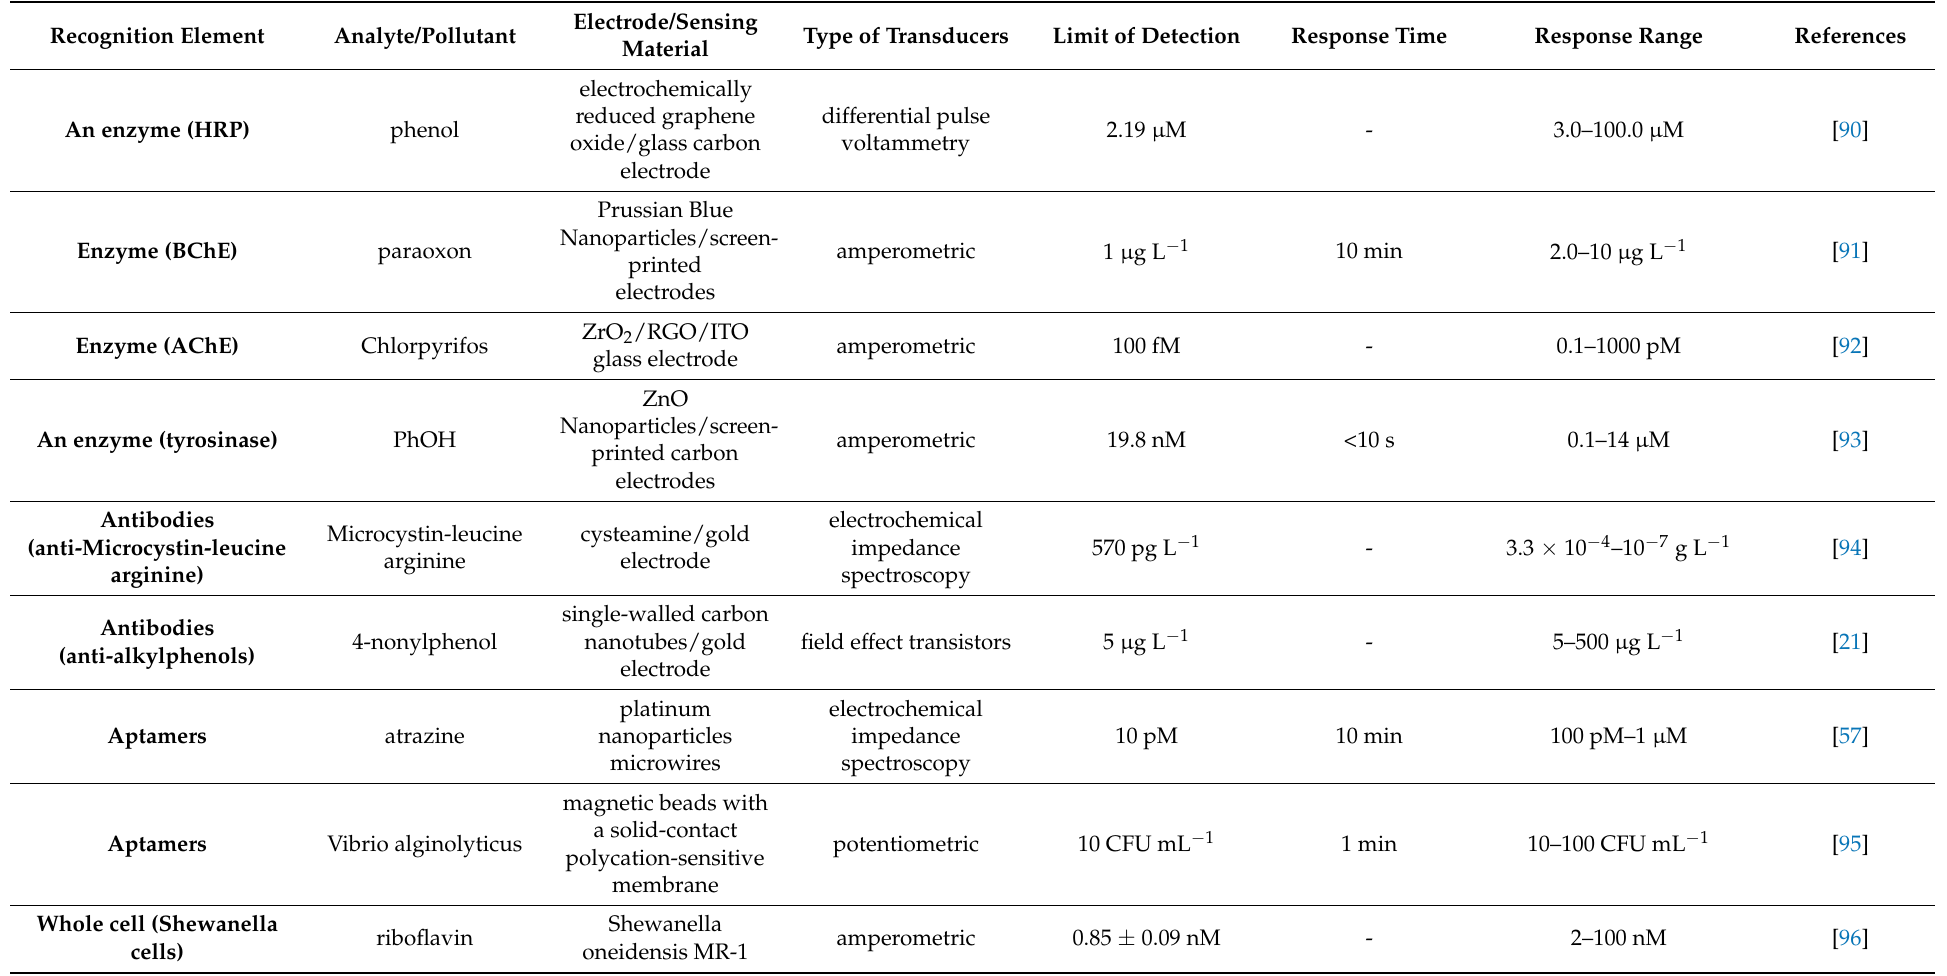
Table 2. Summary of recognition elements, analyte, electrode, type of transducers, the limit of detection, and the response of various electrochemical